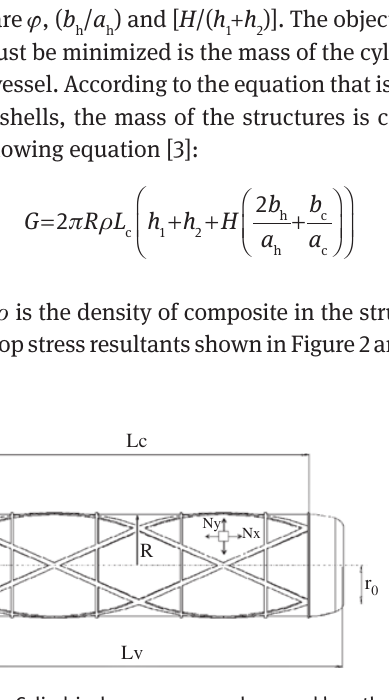
Figure 2 Cylindrical pressure vessel covered by a three-ribbed lattice shell.